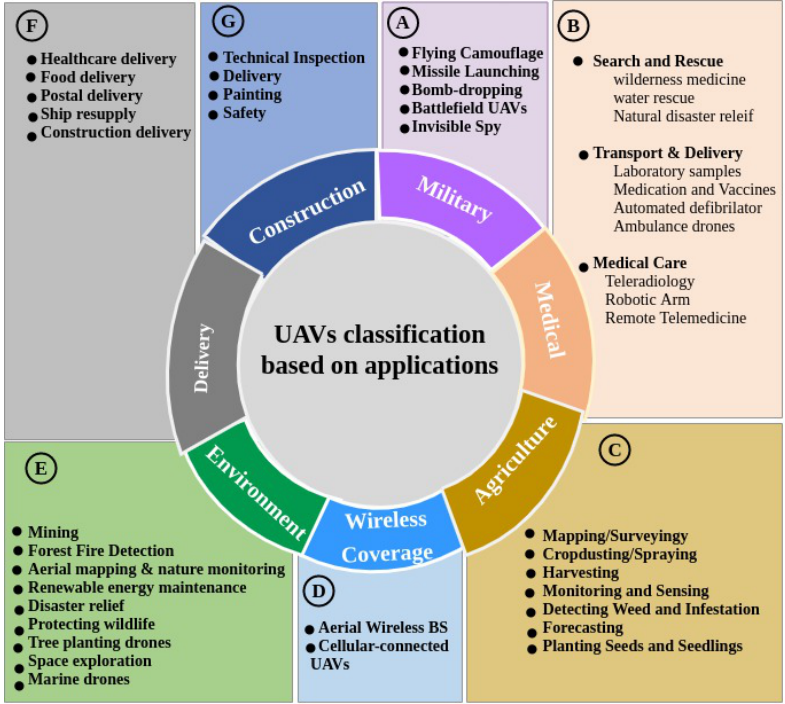
Figure 2. UAV Classification based on application domain: delivery, construction, military, agricul- ture, wireless coverage, and environmental